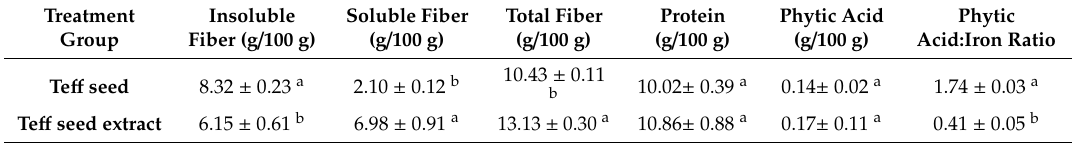
Table 3. Dietary fiber, protein, phytic acid, and phytate:Fe ratio in te ff flour and te ff extract 1 .